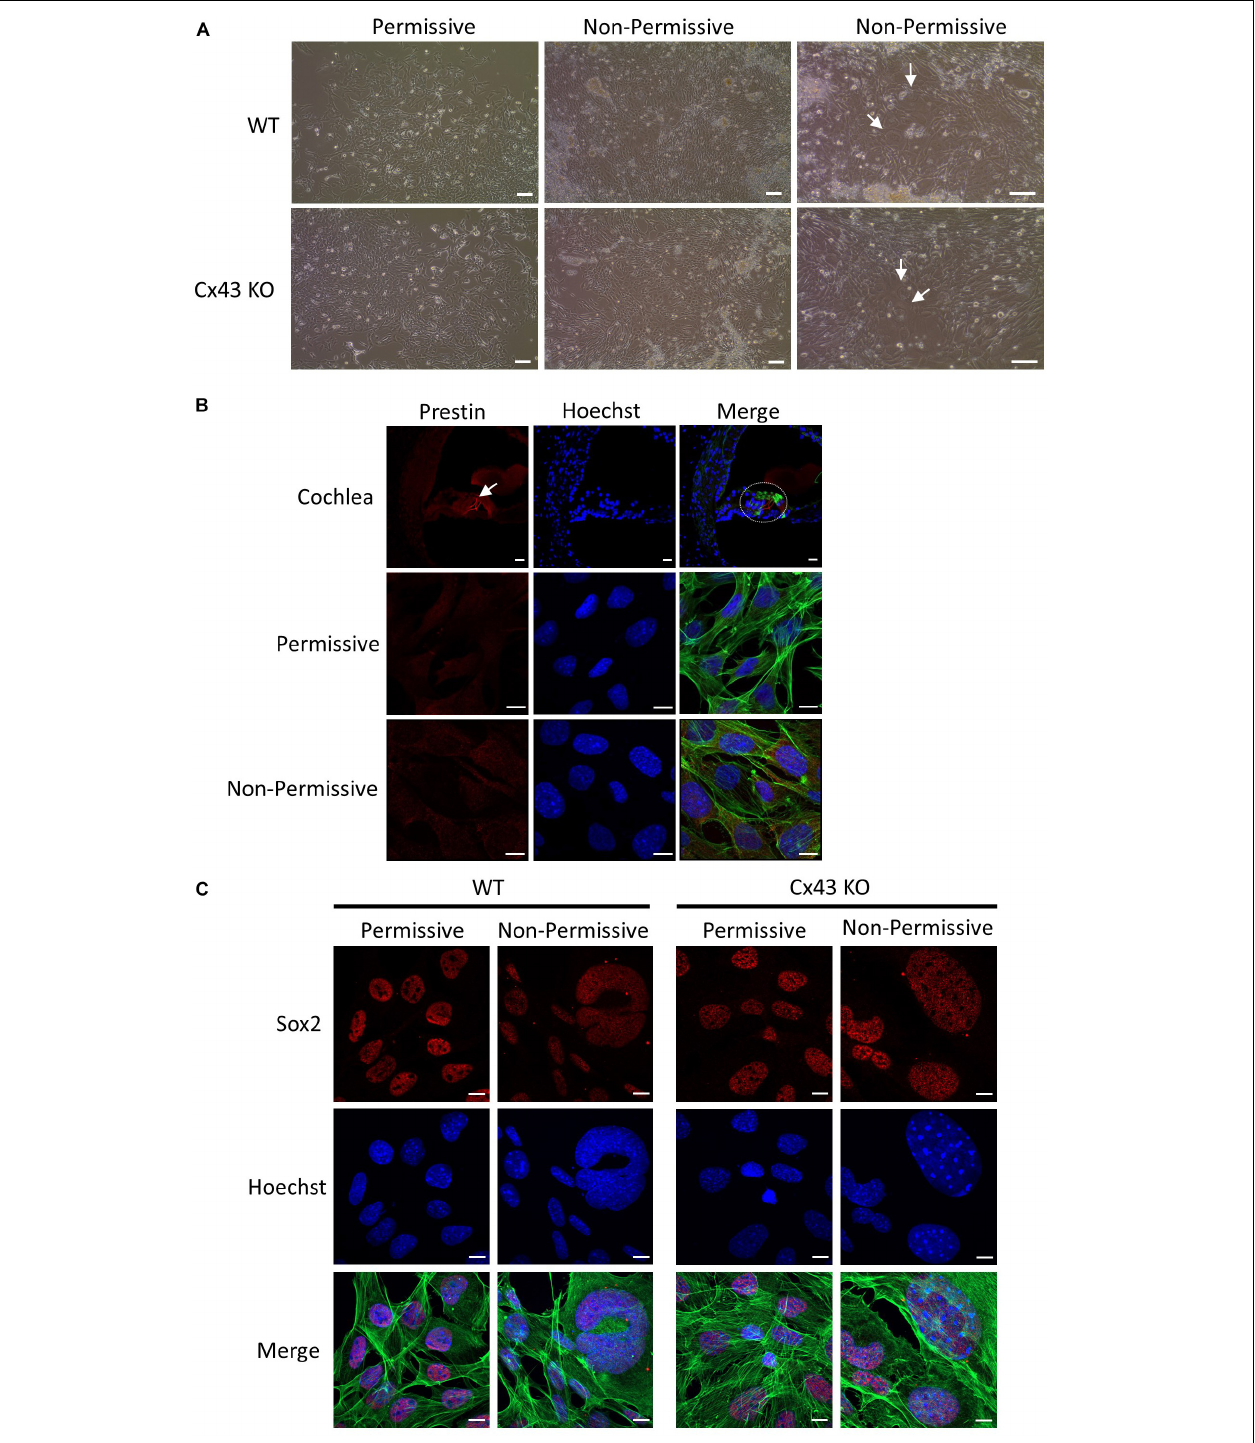
FIGURE 8 | HEI-OC1 cells enlarged but failed to exhibit characteristics of hair cell-like cells when induced to differentiate. (A) Light microscope images of WT and Cx43 KO HEI-OC1 cells grown in permissive and non-permissive conditions for 10 days. Arrows denote large cells that appear to have undergone some level of differentiation. (B) The motor protein prestin (red) was successfully detected in outer hair cells of a postnatal mouse cochlea cross section (dashed oval) but was not detected in WT HEI-OC1 cells grown in permissive or non-permissive conditions. (C) The progenitor cell marker Sox2 (red) expression was detected in HEI-OC1 cells cultured under all conditions. Green = xphalloidin staining, blue = Hoechst stained nuclei. Bars = (A) HEI-OC1 cells = 100 µ m, (B,C) HEI-OC1 cells = 10 µ m, (B) cochlea = 20 µ m.